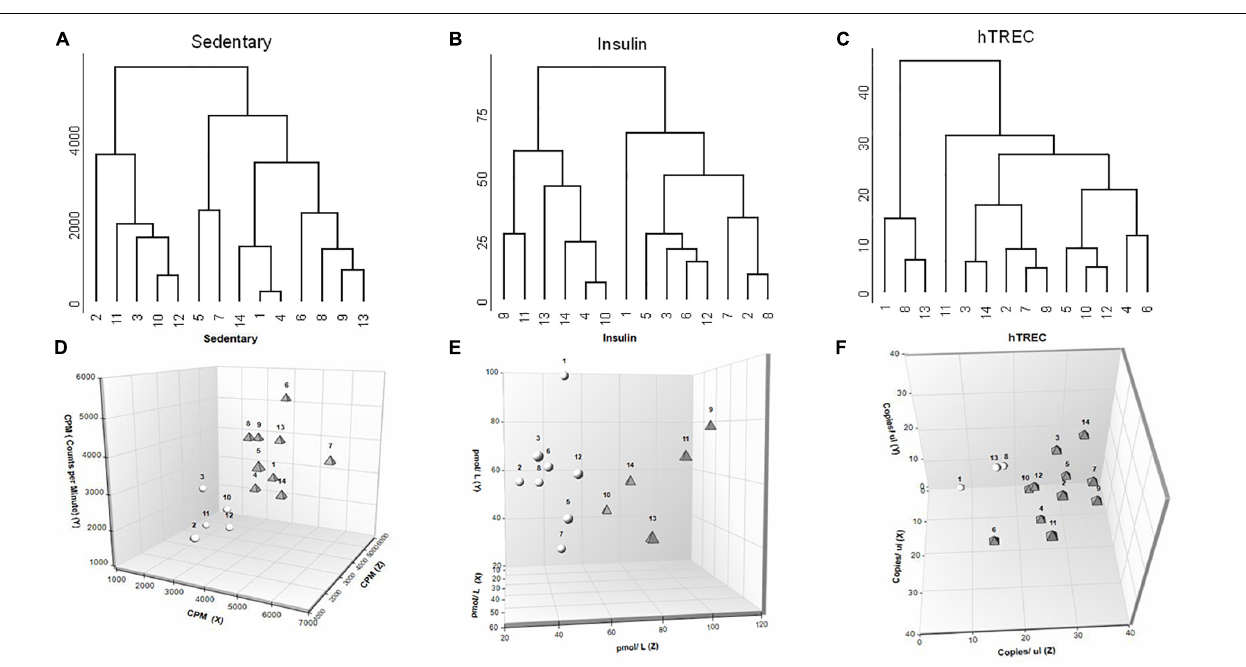
FIGURE 5 | Biostatistics evaluation of physiological and molecular parameters in response to lifestyle program. (A–C) Dendrogram representation shows segregation of participants ( n = 14) for sedentary status, insulin and hTREC. Please note that all three parameters show an early bifurcation indicating segregation into HR and LR individuals. (D–F) 3D plots allow for enhanced visualization of sedentary, insulin and hTREC parameter segregation. Please note the separation of HR and LR individuals ( n = 14) represented by white spheres and gray triangles (view of angle was selected to aid the visualization of separation). X -axis shows baseline (0 month), Y -axis shows mid-term (3 months) and Z -axis shows program exit (6 months)